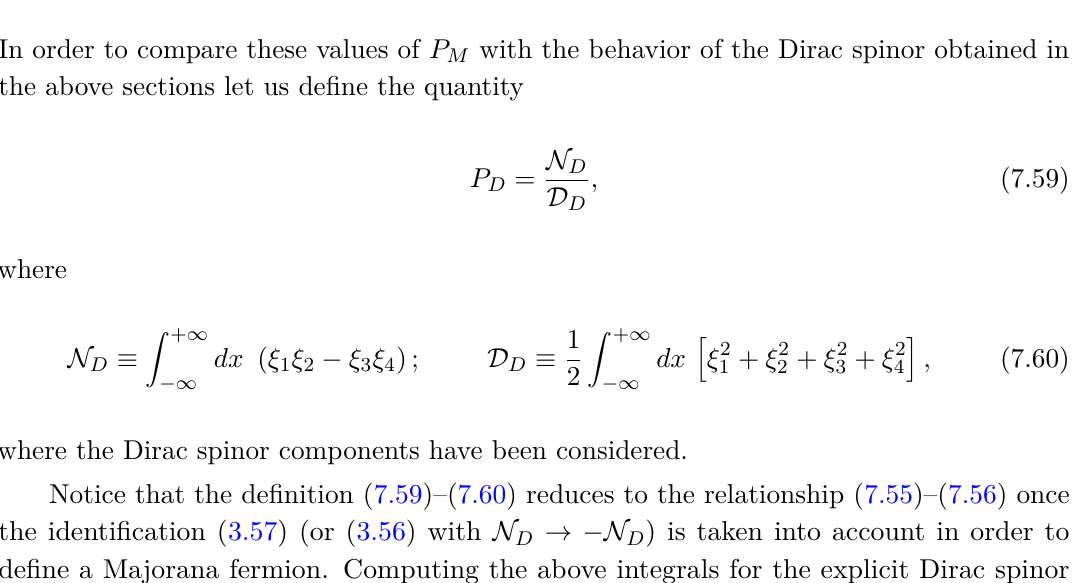
Figure 14 . The plot of the DSG potential V (Φ) in (7.47). Notice the minima for β Φ = 2 π The values Φ = ± π correspond to unstable critical